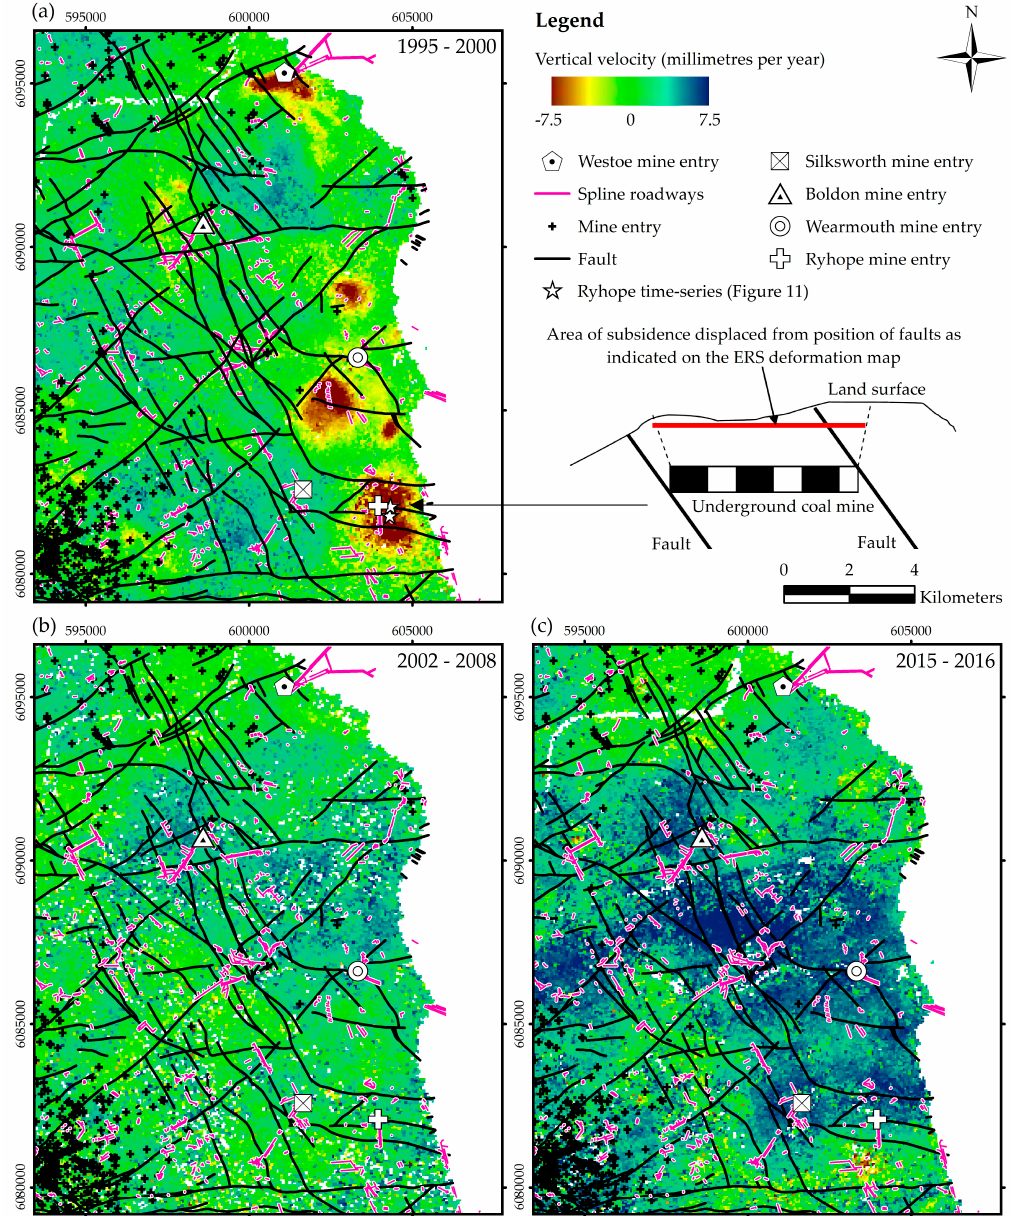
Figure 8. ISBAS vertical velocities (millimetres per year) in the surround area of Sunderland with faults, mine entries and spline roadways overlaid: ( a ) ERS ( b ) ENVISAT ( c )